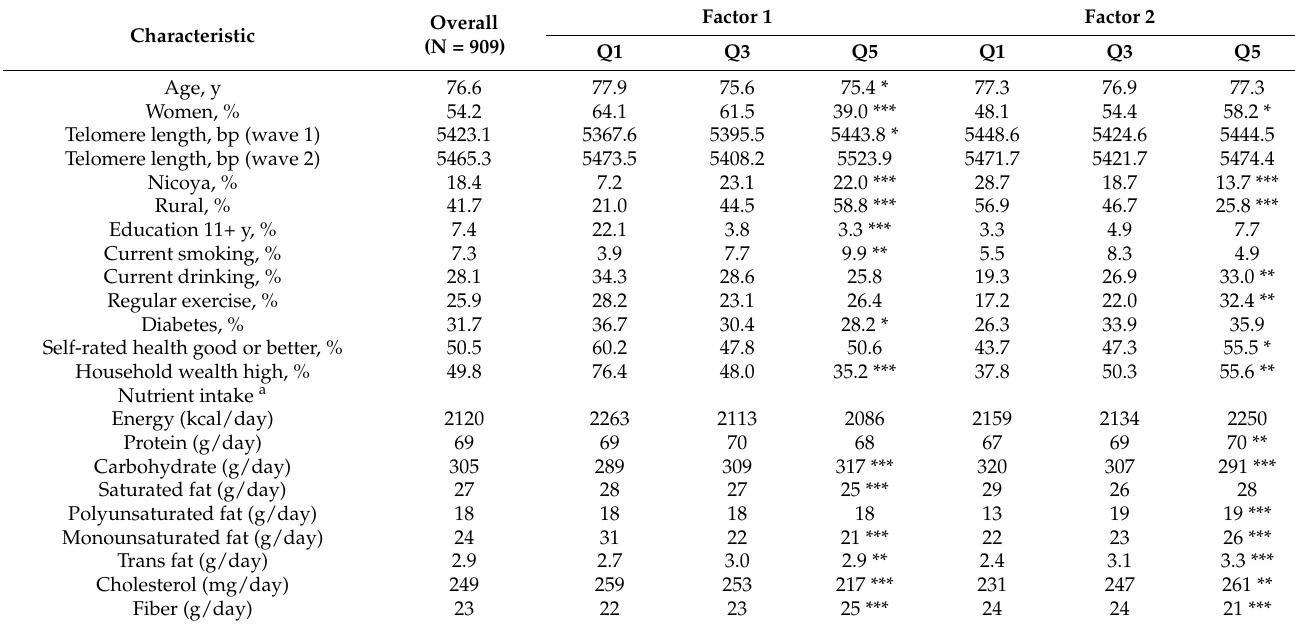
Table 2. Characteristics of the participants: overall and according to quintiles of dietary patterns. Characteristic